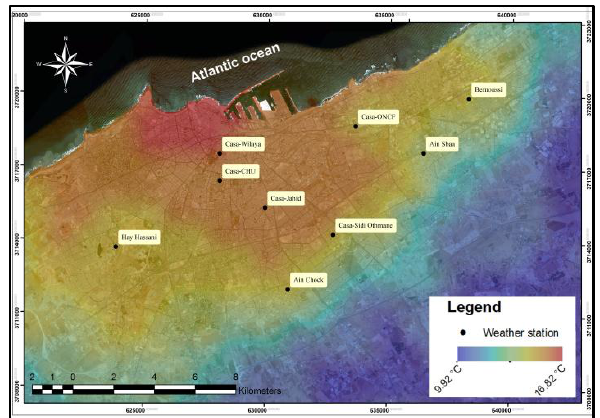
Figure 9. Spatial distribution of minimum air temperature estimated from nighttime MODIS observation during the 19th of March 2012